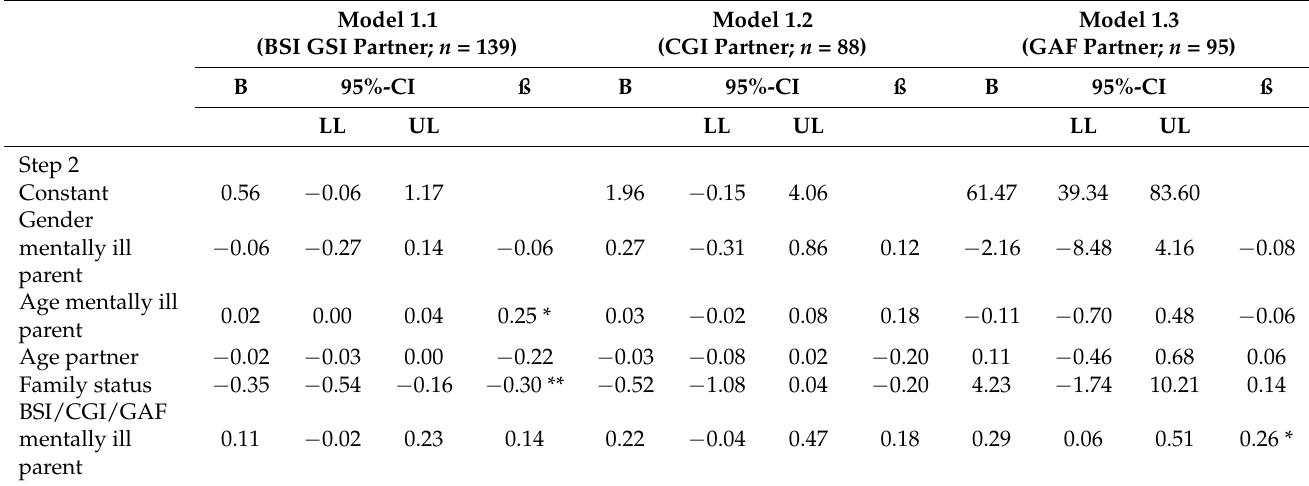
Table 3. Cont. Model 1.1